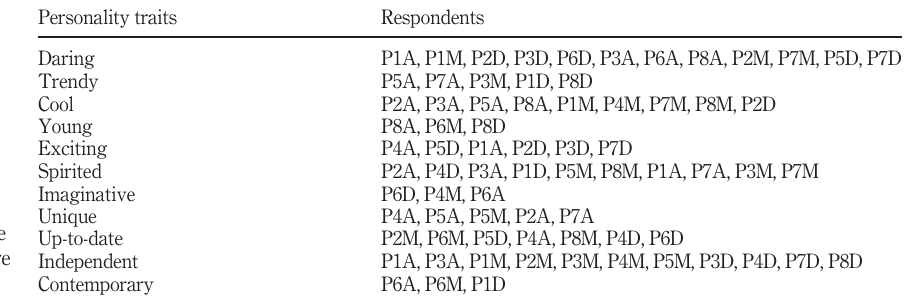
Table VI. Results – projective techniques – picture association